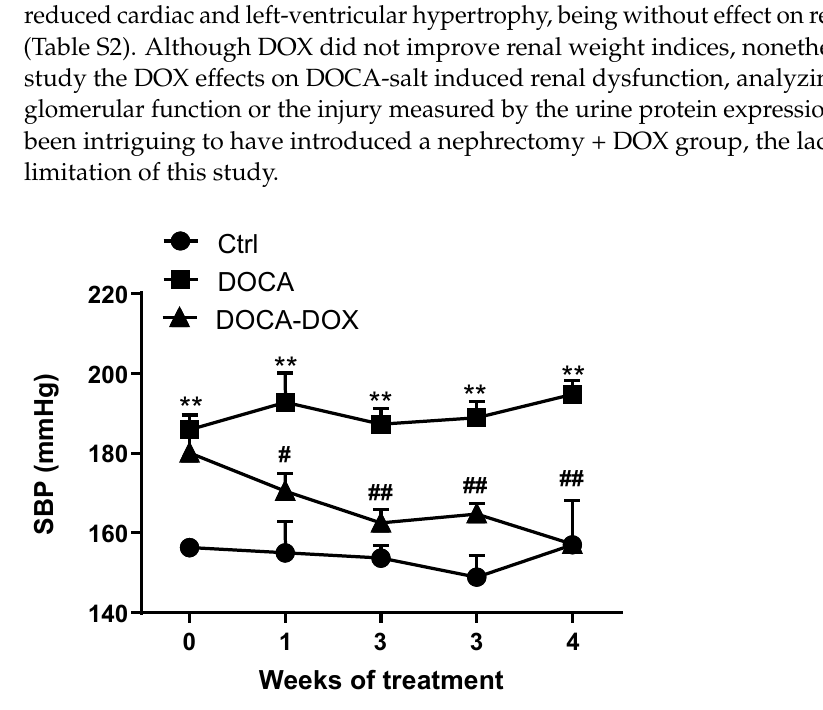
Figure 1. Doxycycline (DOX) prevented the rise in blood pressure in DOCA-salt rats. Time course of systolic blood pressure (SBP) assessed with tail-cuff plethysmography. Results represented as mean ± SEM ( n = 8). ** p < 0.01 versus Control (Ctrl) group. # p < 0.05 and ## p < 0.01 versus the nontreated DOCA group.